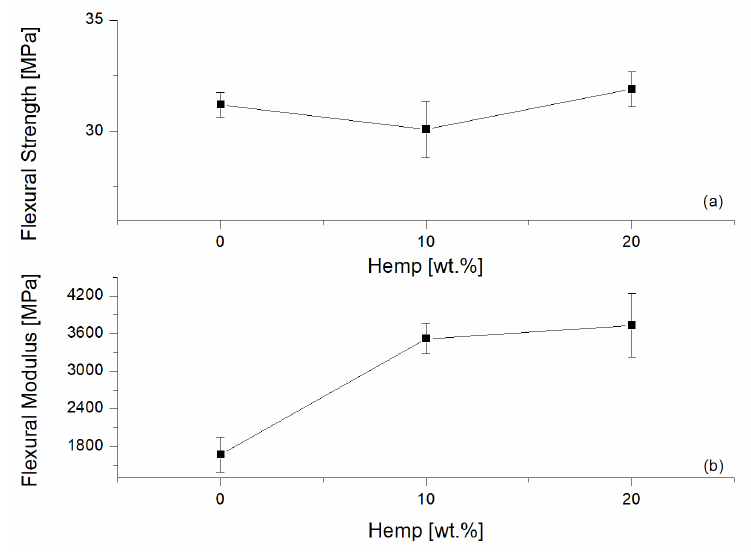
Figure 7. Flexural testing results of the reinforced 60/40 PP/LV blends with different contents of hemp fibers. ( a ) Flexural Strength; ( b ) Flexural Modulus.